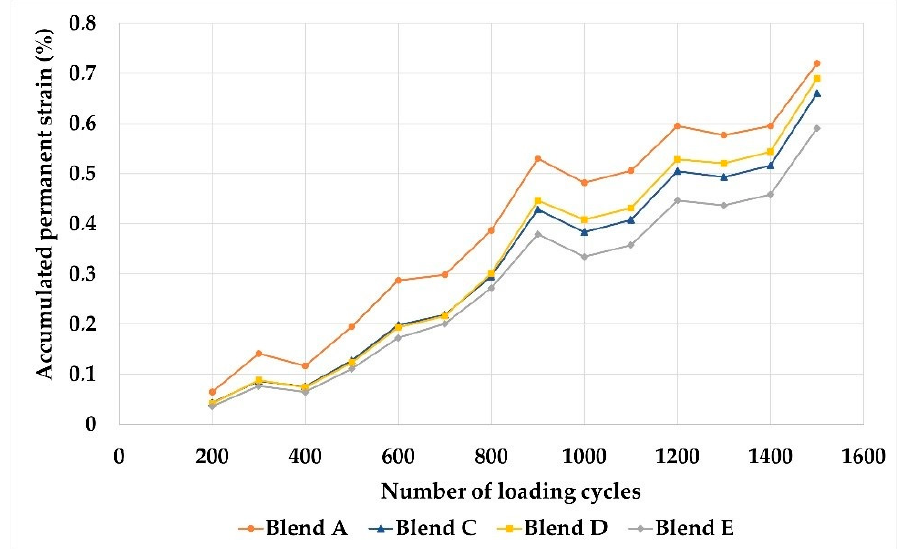
Figure 7. Permanent strains regarding the loading cycles for blends A, C, D and E